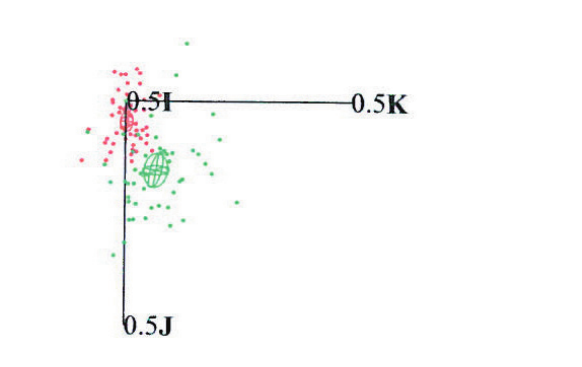
Figure 3. Data collected under 1 D accommodative demand (red points) and 3 D accommodative demand (green points) are shown (95% confidence ellipsoids are included). Separation between the red and green data points is a result of a difference in the mean antistigmatic accommodation that occurred under the two different stimulus conditions. Data from reference